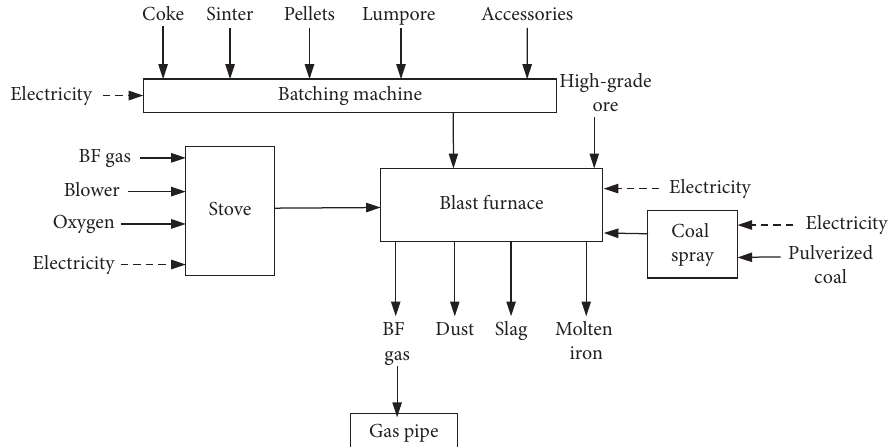
Figure 1: Simplified scheme of iron and steel production routes and